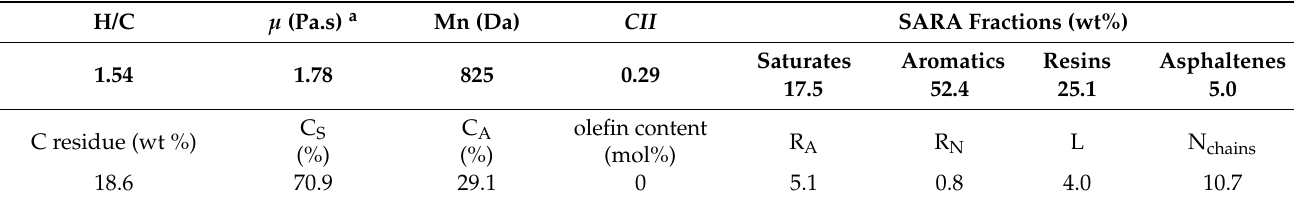
Table 1. Properties of raw heavy oil.